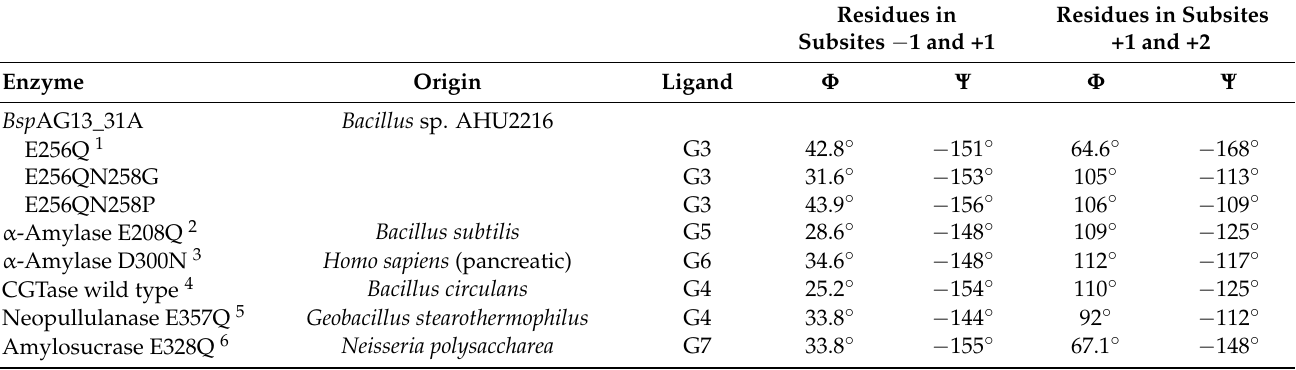
Table 6. Comparison of the torsion angles of G3 bound to BspAG13_31A variants with other GH13